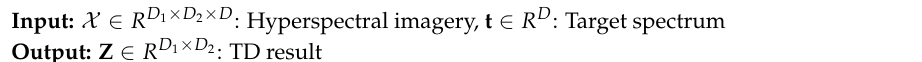
Algorithm 2: TD based on TPCA via Fourier